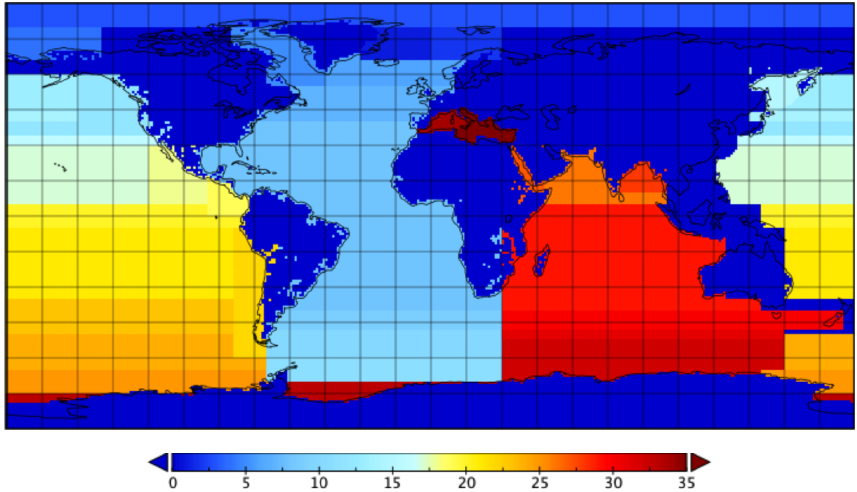
Figure 15. Regions used in reparameterisation of Takahashi et al. (2014). See Table 2 for region